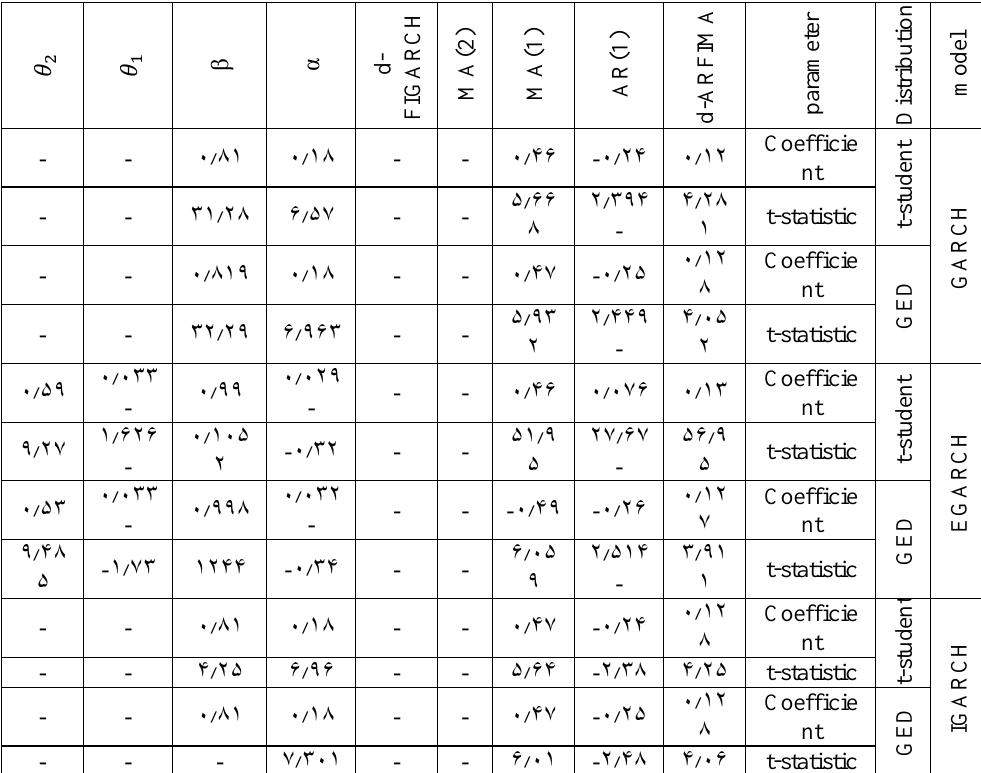
Table 7. GARCH models of the investment